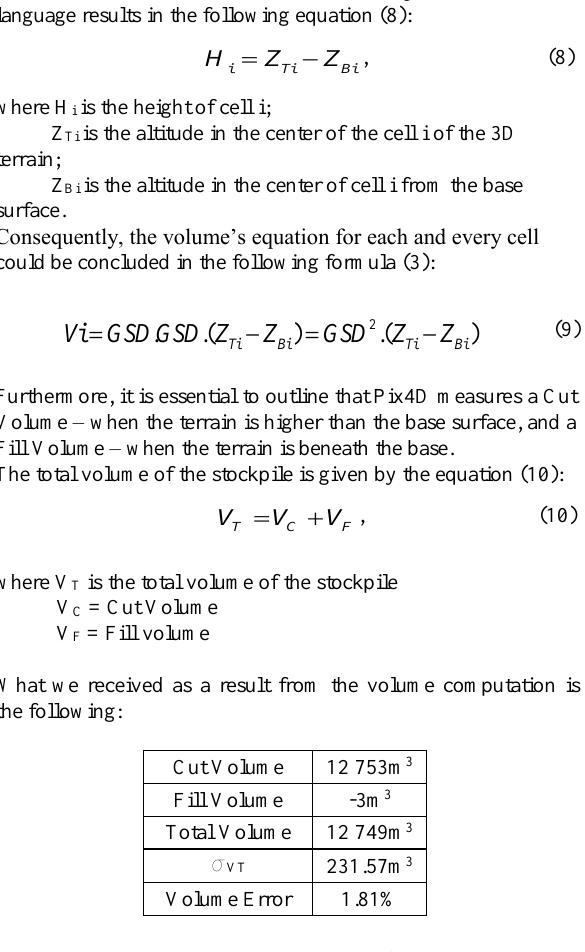
Table 6. Volume calculated in Pix4D from UAV data